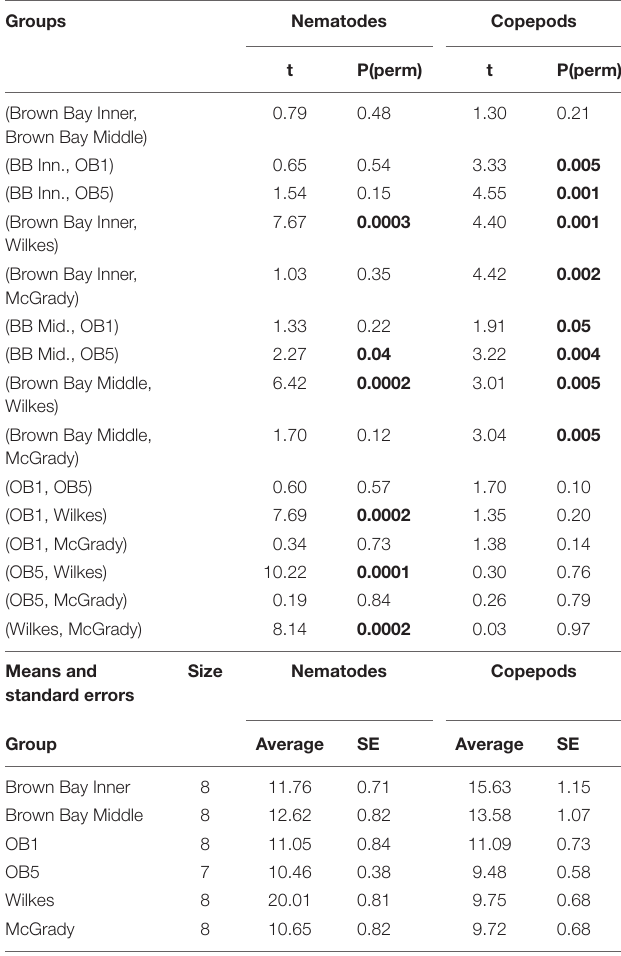
TABLE 4 | PERMDISP analysis of multivariate dispersion in nematode and copepod communities at each location at Casey. Groups